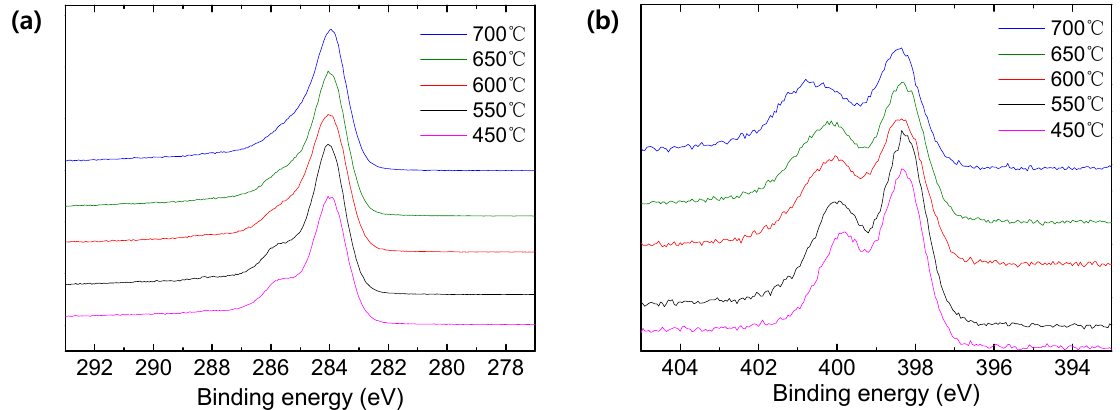
Figure 6. XPS spectra of CMS pyrolyzed at various temperatures ( a ) C1s and ( b ) N1s. On the other hand, the N1s curve contained the peaks of pyridinic N (398.3